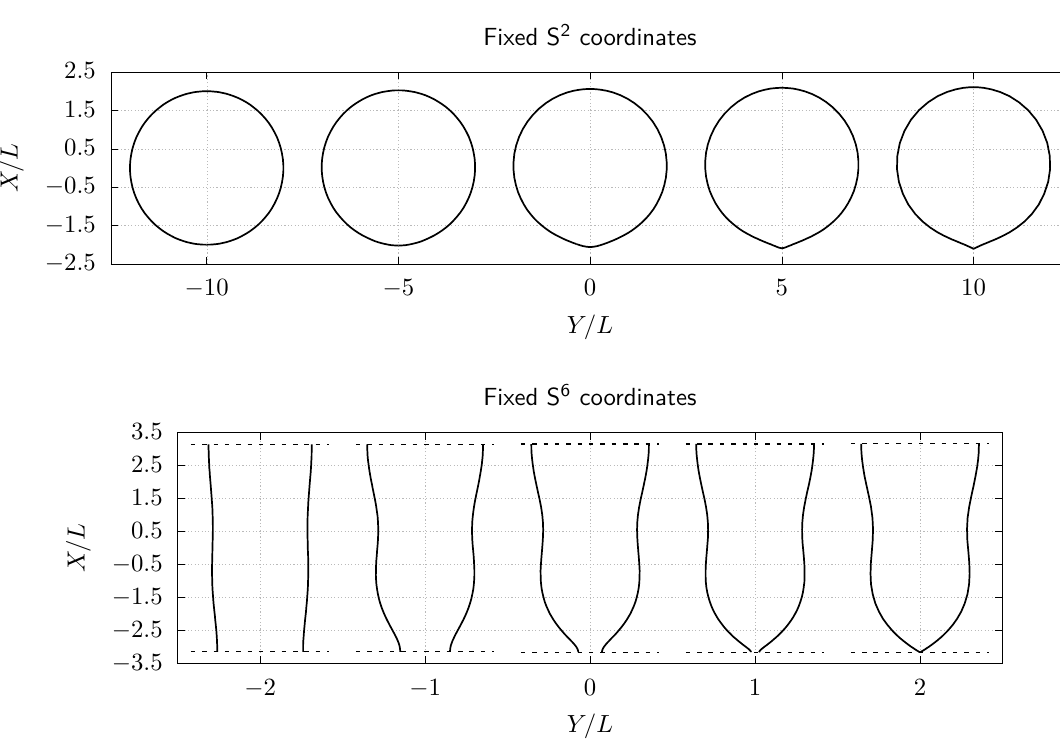
Figure 11. Embedding plots for fixed S 2 /S 6 coordinates of lumpy black holes in AdS 4 × S 7 with ‘ = 1 . This family merges with a localized black hole with S 9 horizon topology. The corresponding plots for ‘ = 3 are similar to those for ‘ = 1 , but the pinch-off appears at the opposite pole.